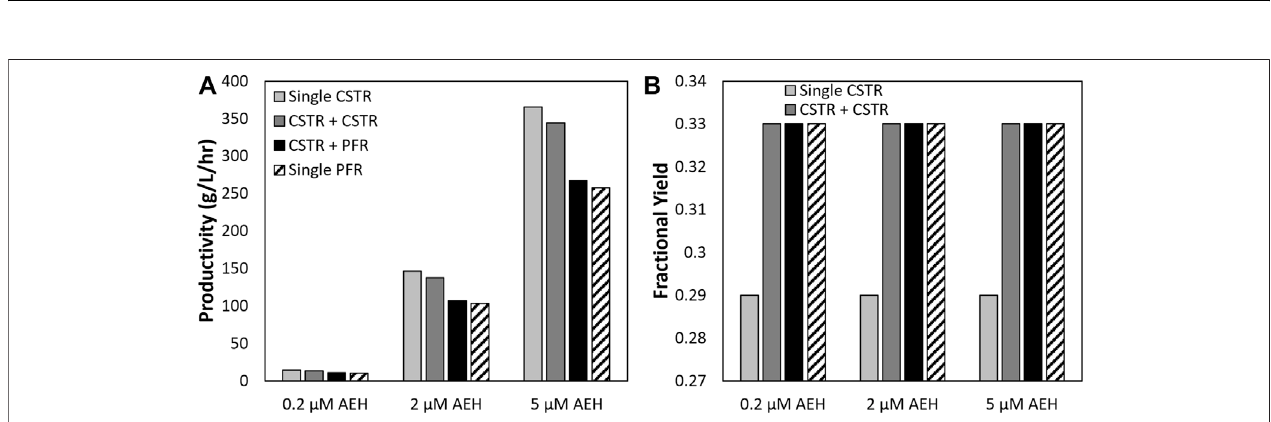
FIGURE 8 | (A) productivities and (B) fractional yields obtained for a single CSTR, single PFR, and CSTR + PFR are shown at varying concentrations of AEH at the maximum 7-ADCA conversion for each respective reactor con fi guration assuming 250 mM PGME and 100 mM 7-ADCA inlet concentrations.